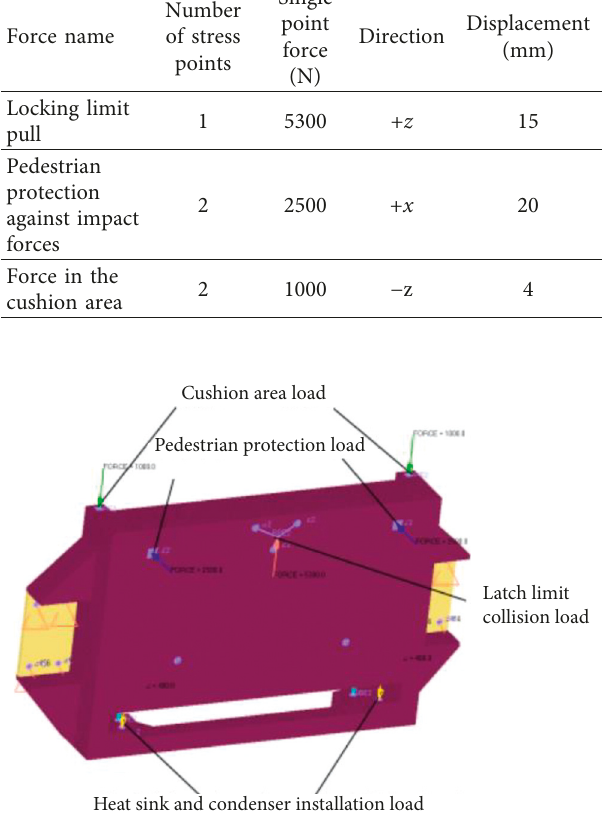
Figure 1: Finite element model of the all-plastic front-end